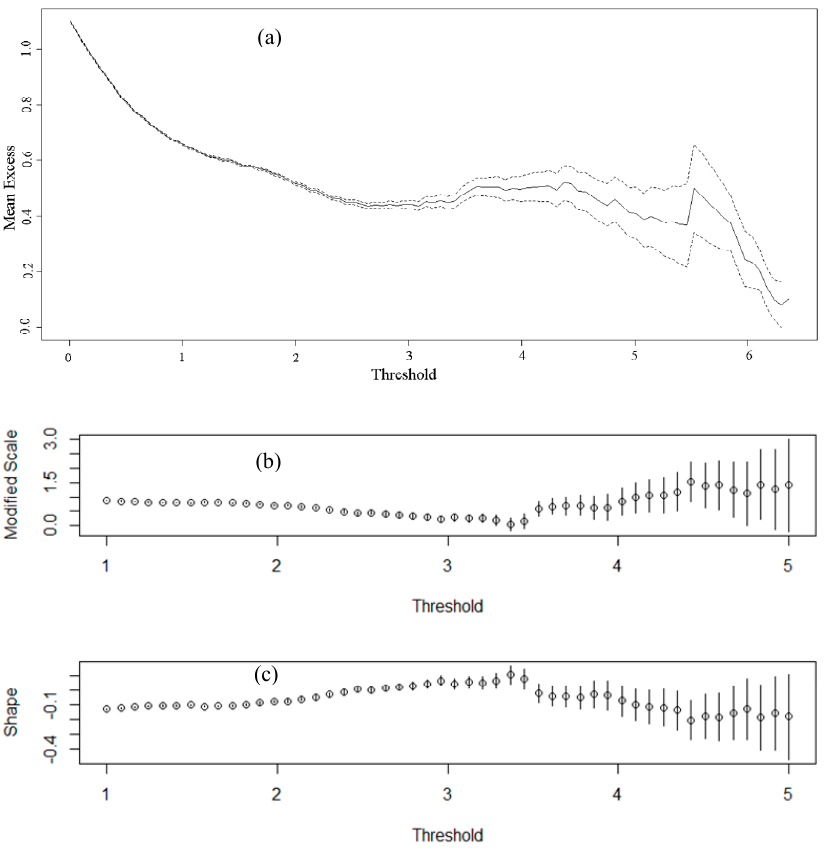
Figure 8. The mean residual life plot with 95% confidence interval based on ‘present’ H smax storm events for the purpose of choosing the storm threshold of GPD ( a ). Scale ( b ) and shape ( c ) parameter estimates against the thresholds for threshold choice revisited purpose.